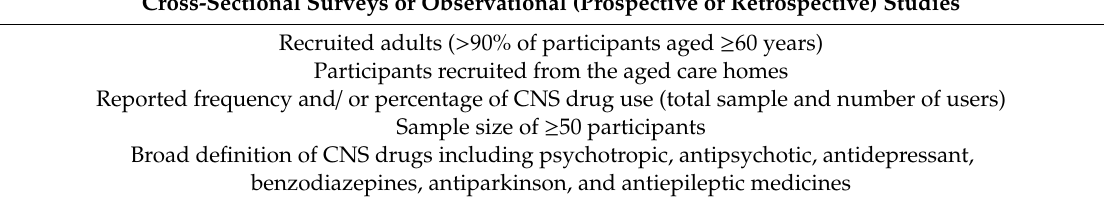
Table 1. Eligibility